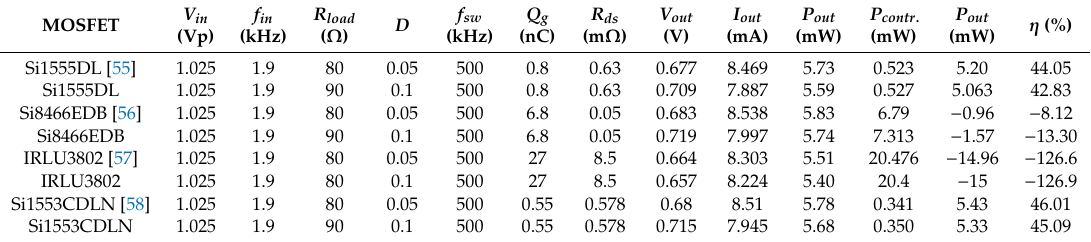
Table 19. Comparative results between di ff erent MOSFETs at 3 m / s.